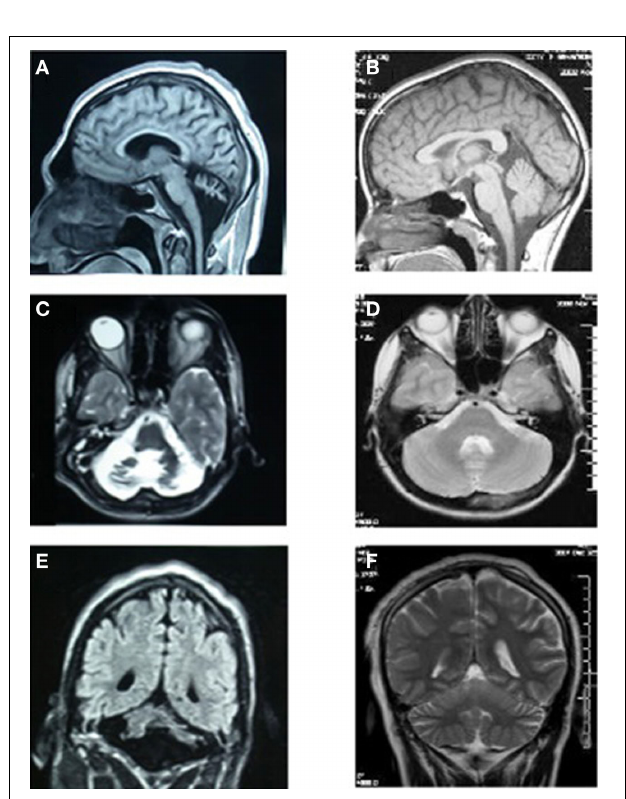
FIGURE 4 | MRI scans of the patient IV-16 (left) and the unaffected relative (right). (A,B): midsagittal; (C,D) : axial; (E,F) : coronal sections.